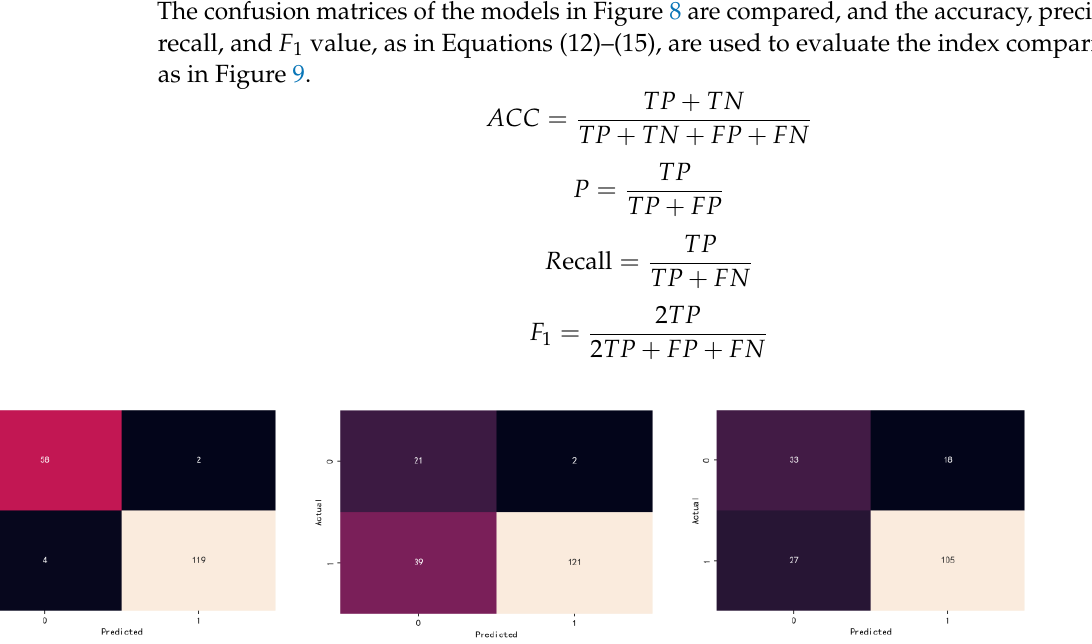
Figure 8. RF, SVM, and KNN confusion matrix comparison. (From left to right, they are RF, SVM, KNN).